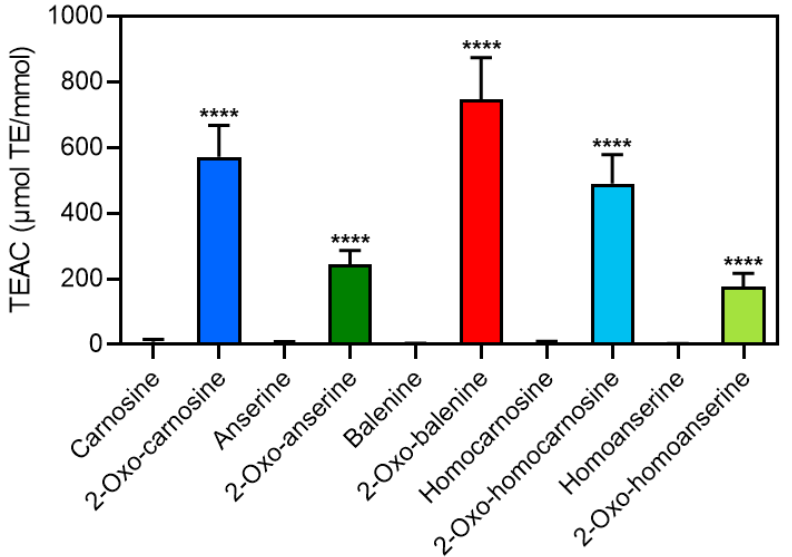
Figure 3. Antioxidant capacity of 2-oxo-IDPs and IDPs. Antioxidant capacity of 2-oxo-IDPs and IDPs were evaluated by DPPH radical scavenging assay. Data are expressed as Trolox equivalent antioxidant capacity (TEAC): µmol Trolox equivalent (TE) per mmol samples. Data are presented as means ± standard deviation (SD) ( n > 6). **** p < 0.0001 versus the corresponding IDPs, compared using unpaired Student’s t test.